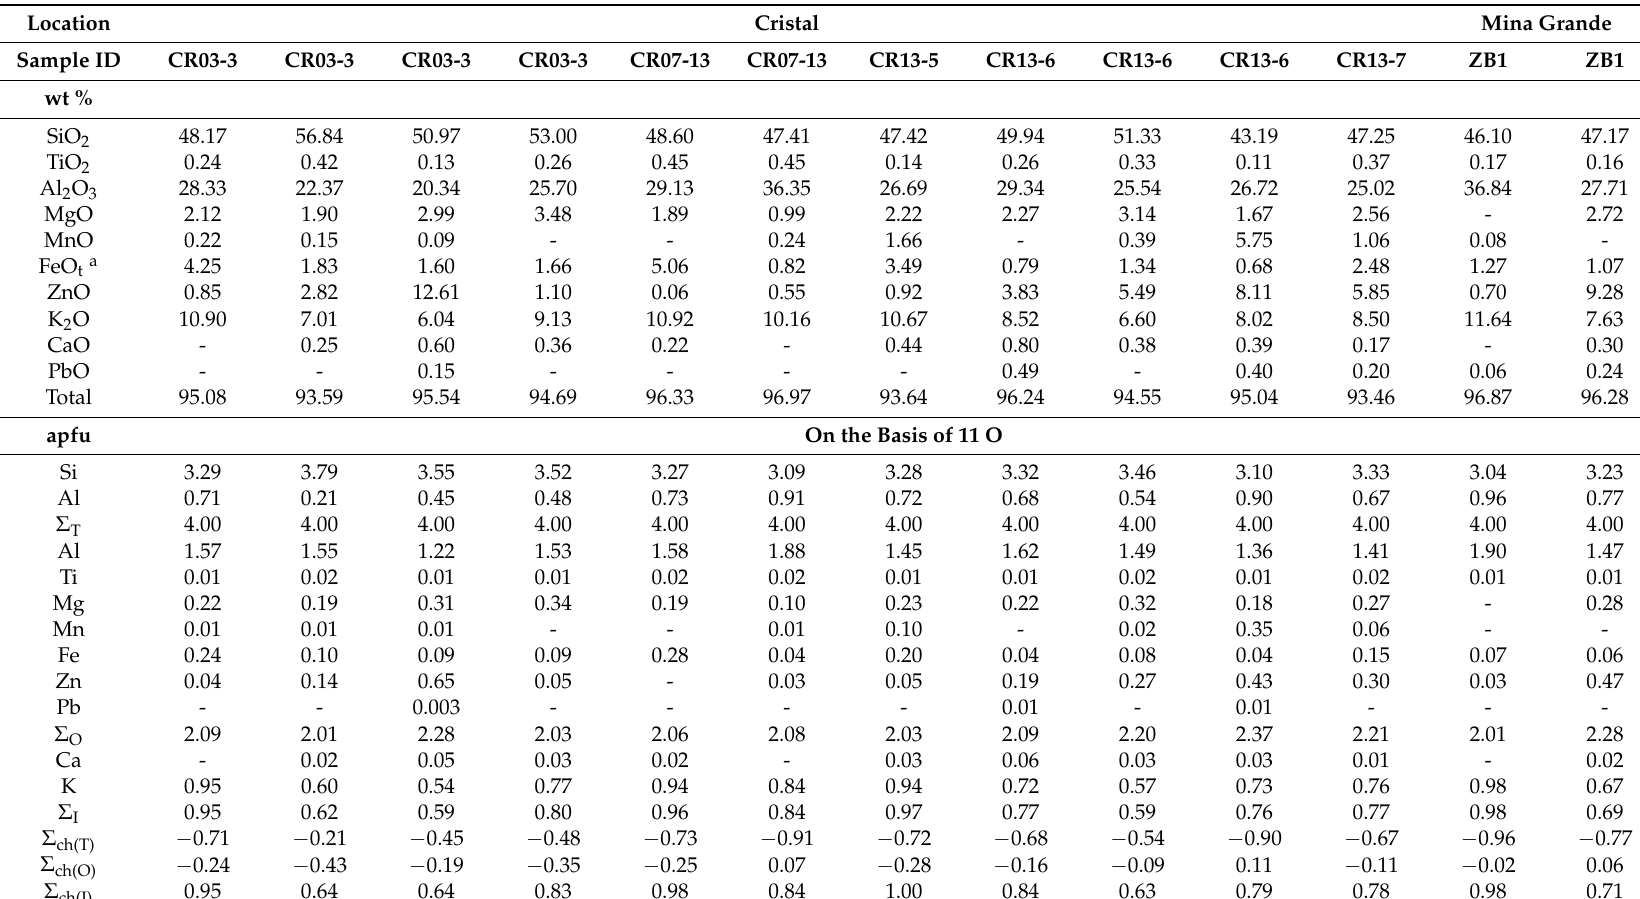
Table 1. Chemical composition and structural formulae (apfu) of Zn-bearing micas from the Cristal (CR samples) and Mina Grande (ZB samples) deposits.